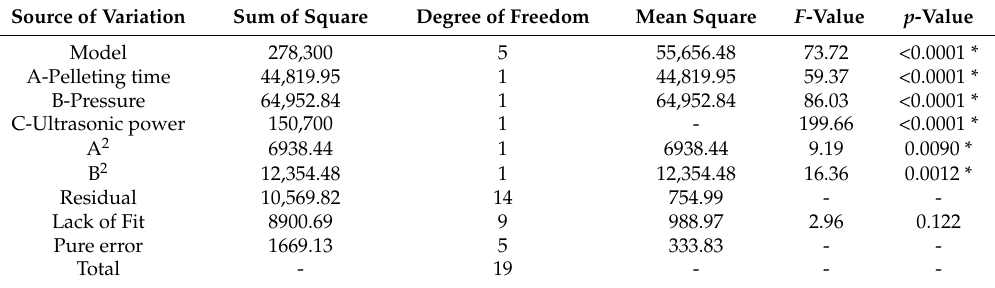
Table 3. The ANOVA results of pellet density in a reduced